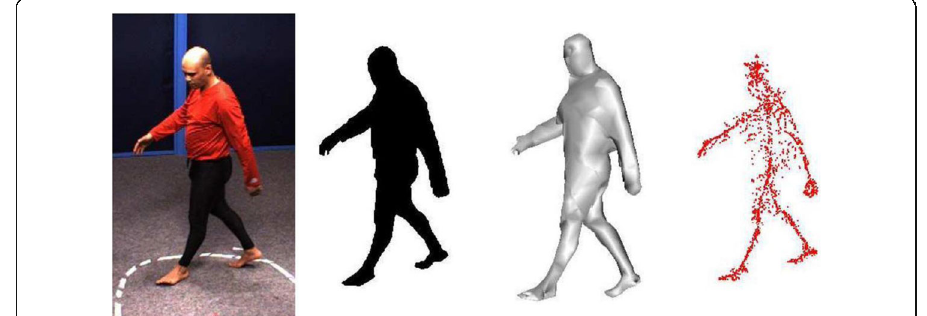
Fig. 2 Schematic diagram of human motion capture (picture from